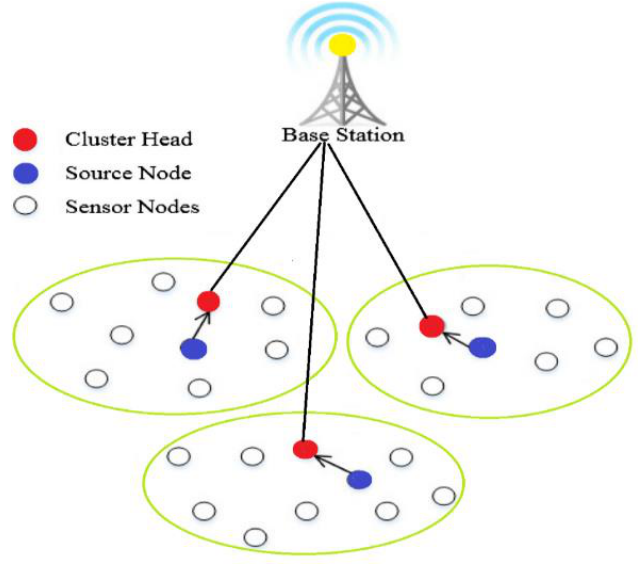
Figure 4. Basic structure of the proposed protocol.